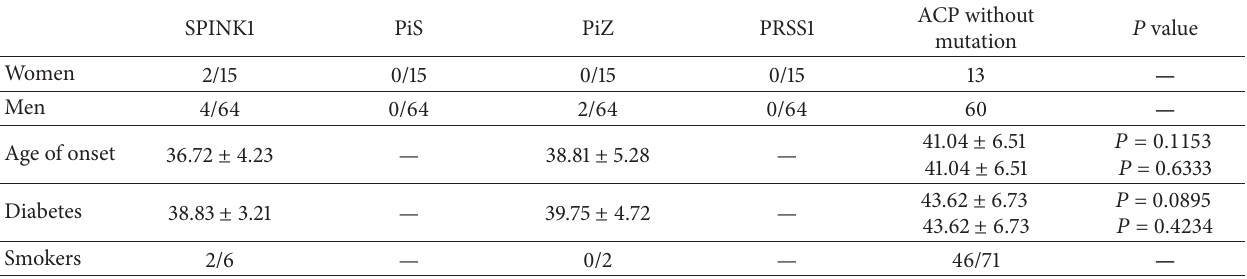
Table 4: Clinical and genetic characteristics of patients with